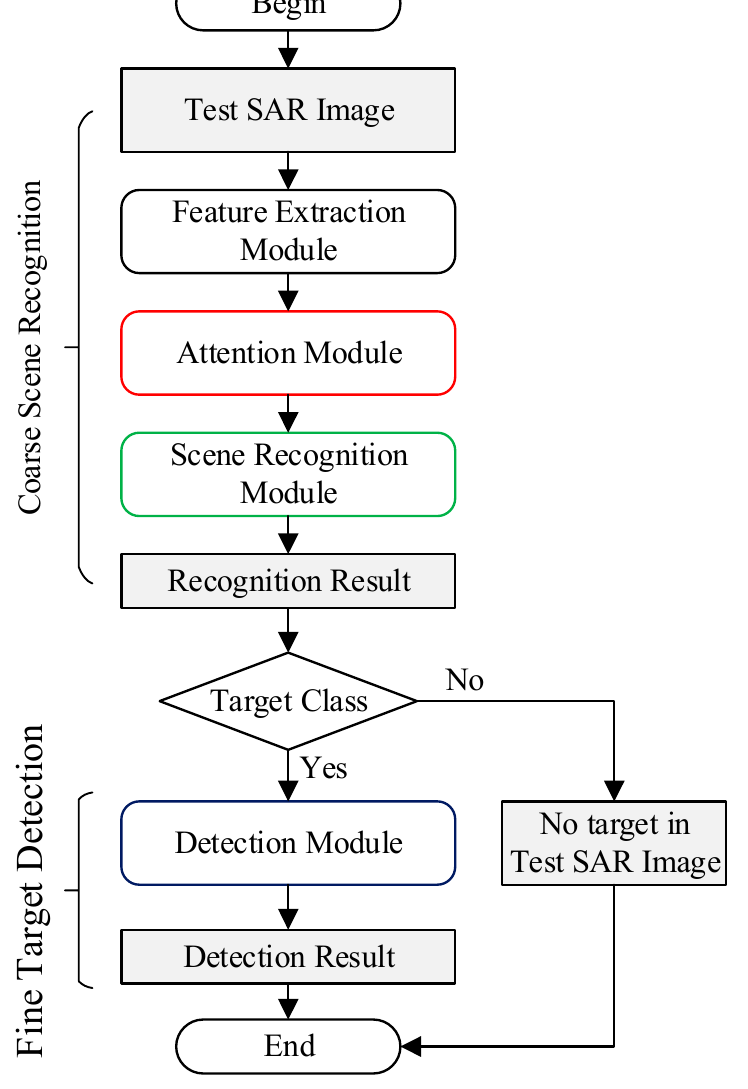
Figure 4. Flowchart of the proposed coarse-to-fine SAR target detection procedure.